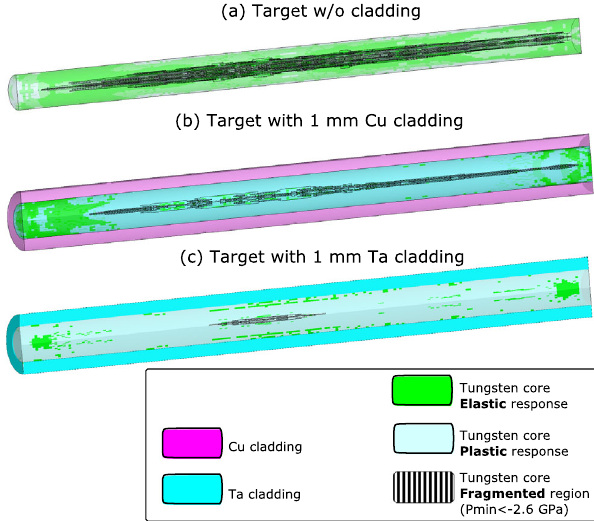
FIG. 13. Figure showing the state of the target core material after a proton pulse impact considering minimum hydrostatic ¼ − 2 . 6 GPa). The figure shows failure model in tungsten. ( P min results for the three scenarios of study, demonstrating the efficacy of Ta cladding for reducing the internal core